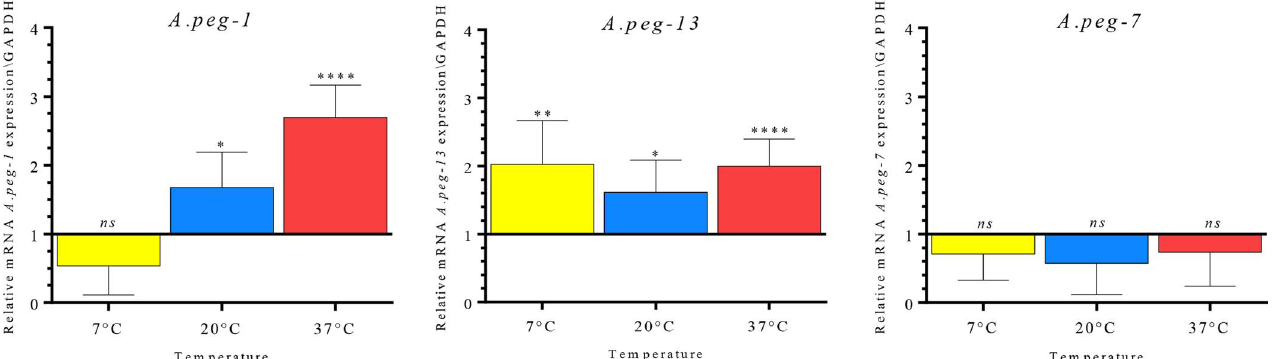
Figure 4. Relative expression pro fi les of the gene coding for the ESPs proteins, A.peg-1, A.peg-7, A.peg-13 (shown vertically on the right side of the graph), normalised to the geometric mean of GAPDH ( gpd2 ), in A. pegref fi i larvae, in response to temperature conditions (7 (cid:1) C, 20 (cid:1) C and 37 (cid:1) C, after 24 h). The control at 2 (cid:1) C is shown as normalised to a value of 1. Each value represents the M ± SD of three biological replicates. Signi fi cant differential expression was assessed by Student ’ s t test. Signi fi cance was fi xed at p < 0.05 [* p < 0.05, ** p < 0.01, *** p < 0.001, p < 0.0001].